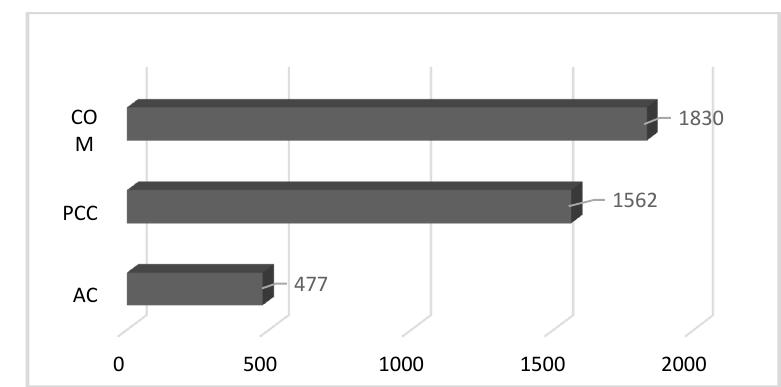
Figure 2. Number of sections in each pavement types. Table 1. Summary statistic of pavement sections.